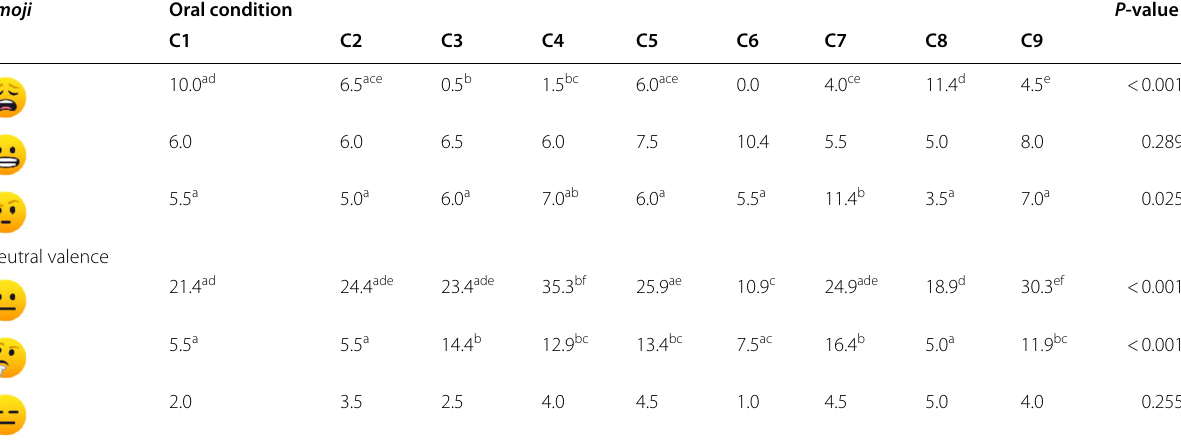
C1—crowding, C2—anterior open bite, C3—interincisal diastema, C4—increased overjet and deep bite (Class II division 1), C5—anterior crossbite (Class III), C6—ideal occlusion, C7—unilateral posterior crossbite, C8—anterior open bite plus bilateral posterior crossbite plus crowding, C9—deep bite (Class II division 2) a, b,c,d,e,f,g Different superscript letters indicate difference between conditions in the same row † The conditions for comparison between the groups using the McNemar test were not met